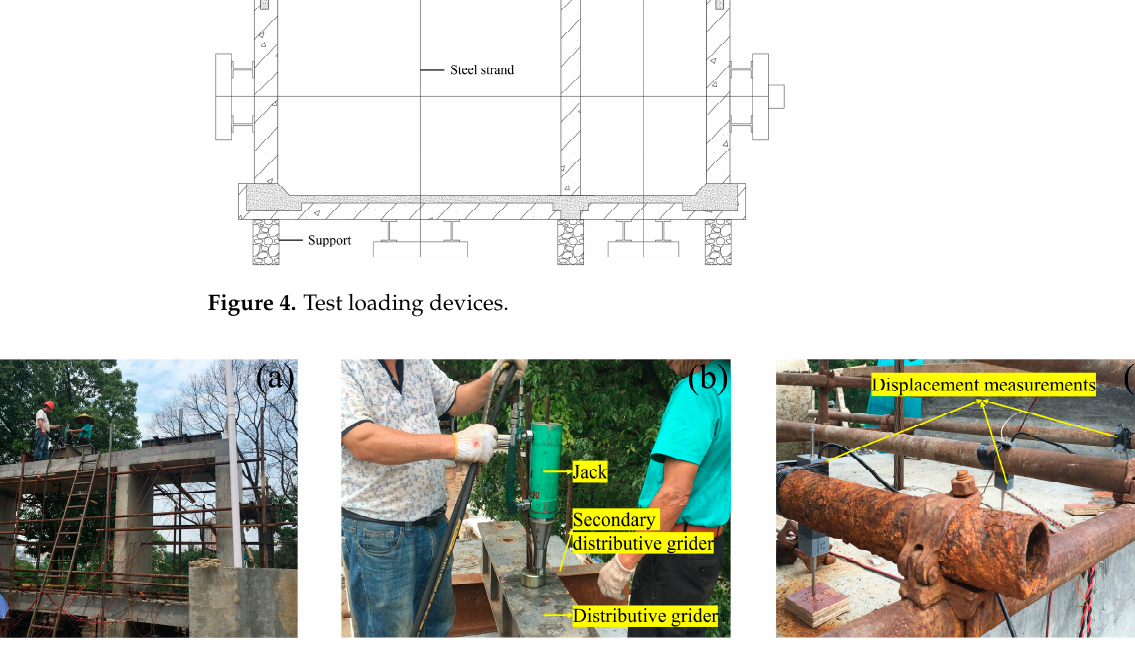
Figure 6. Distribution of displacement measurement points. 3.3. Test Results and Analyses of the Prefabricated Underground Utility Tunnel 3.3.1. Crack Development Process When the large-span plate load reached 435 kN, the small-span plate and lateral-wall loads were 196 kN and 289 kN, respectively (Table 2). There was no crack in the structure of the prefabricated utility tunnel. The following description of the crack development in the full-scale structure is based on the loads applied to the large-span plate. When the load was increased to 507 kN, the first flexural crack appeared in the tensile area of the large- span top plate at 400 mm away from the middle-wall support. At a load of 579 kN, two cracks, with a length of approximately 150 mm, appeared in the tensile zone near the mid- dle-wall support and the lateral-wall support of the large-span top plate. In addition, sev- eral microcracks appeared in the tensile zone in the middle of the large-span top plate. When the load reached 650 kN, two microcracks appeared in the tensioned area in the span of the large-span bottom plate. Additionally, two cracks appeared in each of the large-span and small-span lateral walls near the top plate support, and the cracks ex- panded along the segmental direction. The cracks developed at the beginning of the test, as shown in Figure 7.